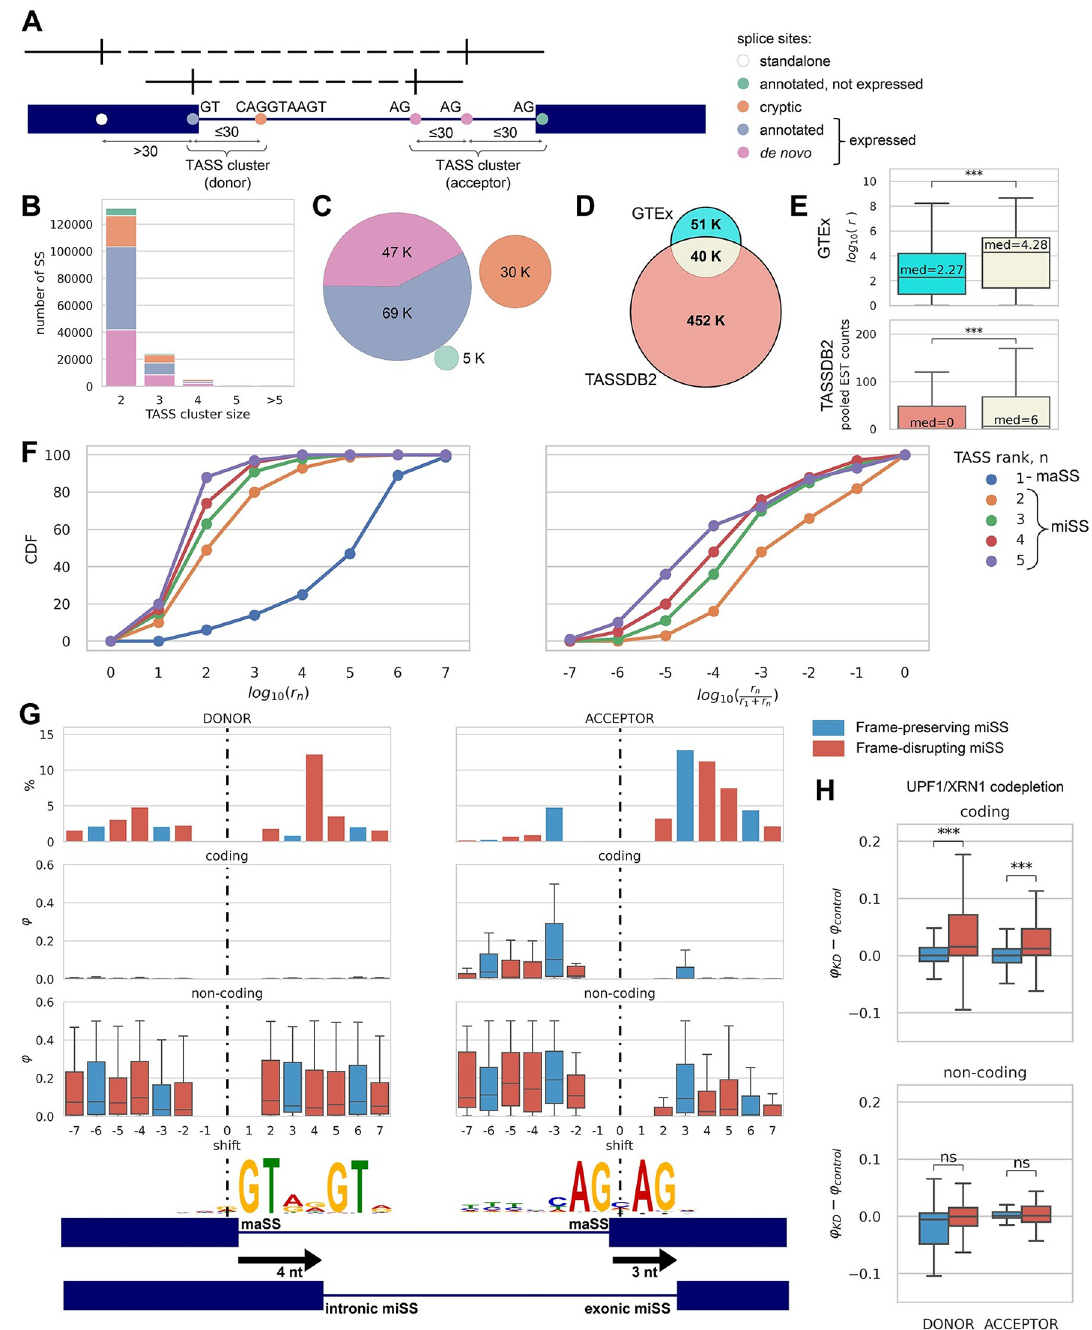
Fig 1. The catalogue of TASS. (A) Splice sites are categorized as annotated (GENCODE and Refseq), de novo (inferred from RNA-seq) or cryptic (detected by SpliceAI). TASS clusters consist of splice sites of the same type (donor or acceptor) such that each two consecutive ones are within 30 nts from each other. (B) The TASS cluster size distribution. (C) The number of annotated, de novo and cryptic TASS. Colors are as in panel (A). (D) The catalogue of TASS and TASSDB2 database. Only TASS separated by 2-12 nt were counted to match the TASSDB2 content. (E) The distributions of the total number of read counts in GTEx (top) and the total number of EST counts provided in TASSDB2 (bottom) for the three TASS categories in panel (D). (F) The expression of the major splice sites (maSS, i.e. rank 1) and minor splice sites (miSS, i.e. rank 2 or higher). Left: the cumulative distribution of r n , the number of split reads relative to the sum of r and r 1 . (G) The distribution of shifts, i.e., the supporting maSS and miSS. Right: the cumulative distribution of r n n positions of miSS relative to maSS (top) for miSS of rank 2. The relative usage of miSS ( φ ) in coding (middle) and non-coding regions (bottom). Logo chart of miSS sequences of +4 donor shifts and of +3 acceptor shifts. Frame-preserving shifts are colored blue and frame-